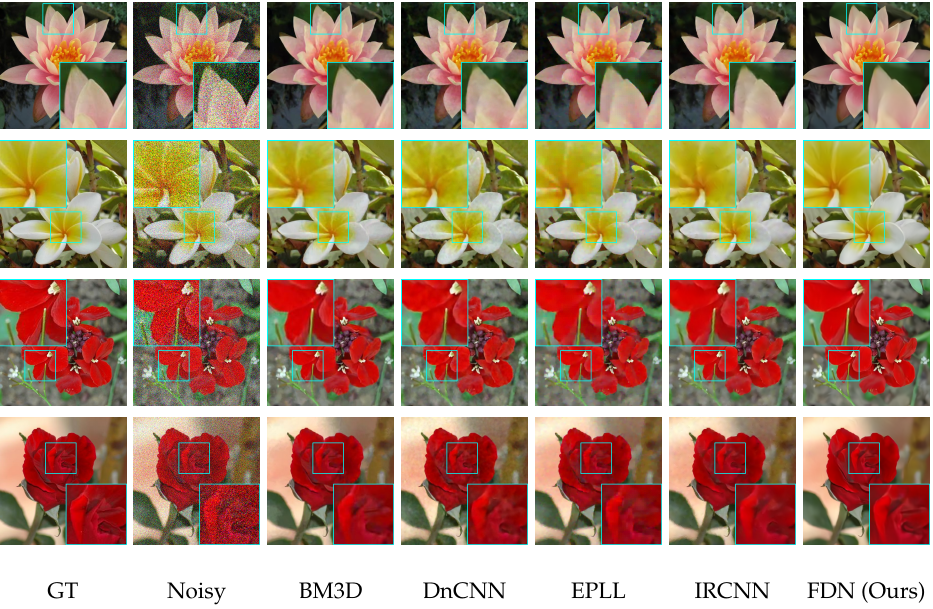
Figure 8. Visual comparison on the Flower dataset for σ = 50 against state-of-the-art